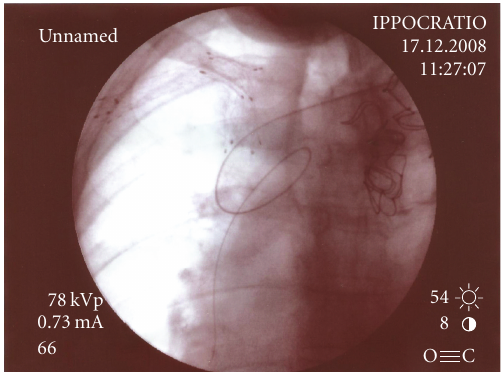
Figure 4: Through the long guiding catheter the pacing lead is advanced to the right ventricle and screwed in the endocardial